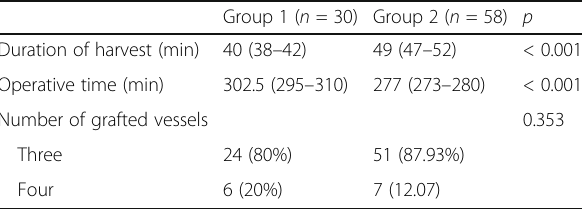
Table 2 Operative data comparison between the two